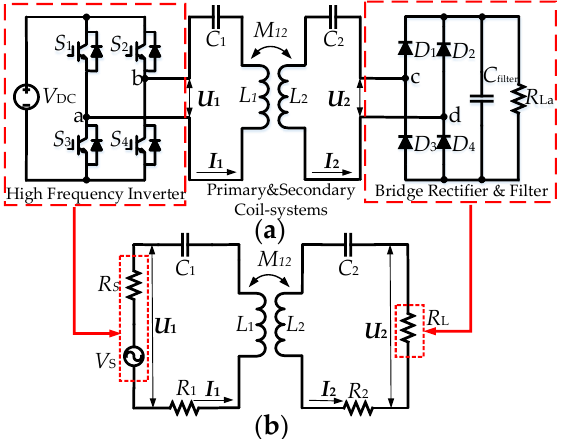
Figure 1. Wireless power transfer (WPT) system: ( a ) Whole system; ( b ) simplified model.